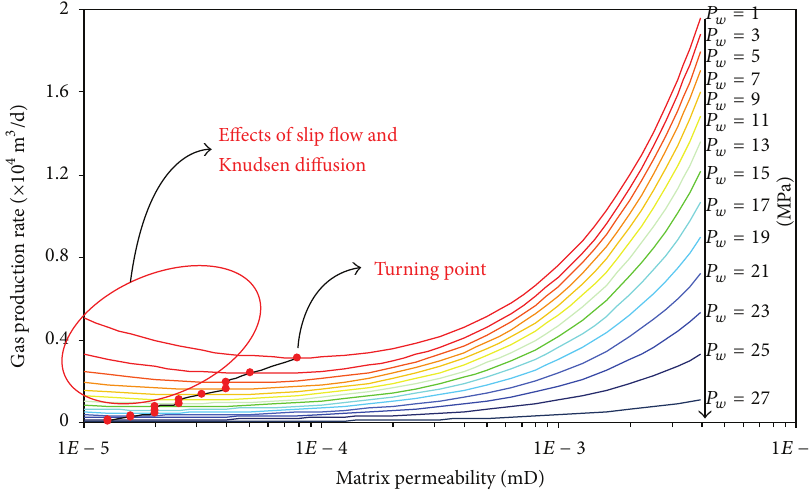
and slip factor 𝑏 on productivity. K